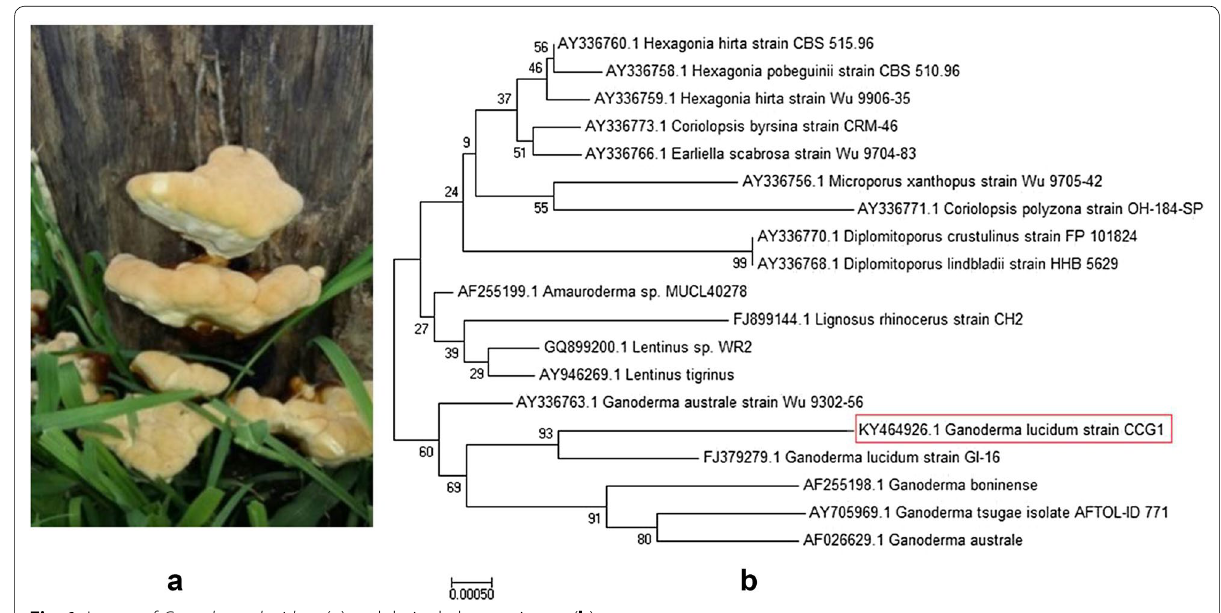
Fig. 1 Image of Ganoderma lucidum ( a ) and their phylogenetic tree ( b